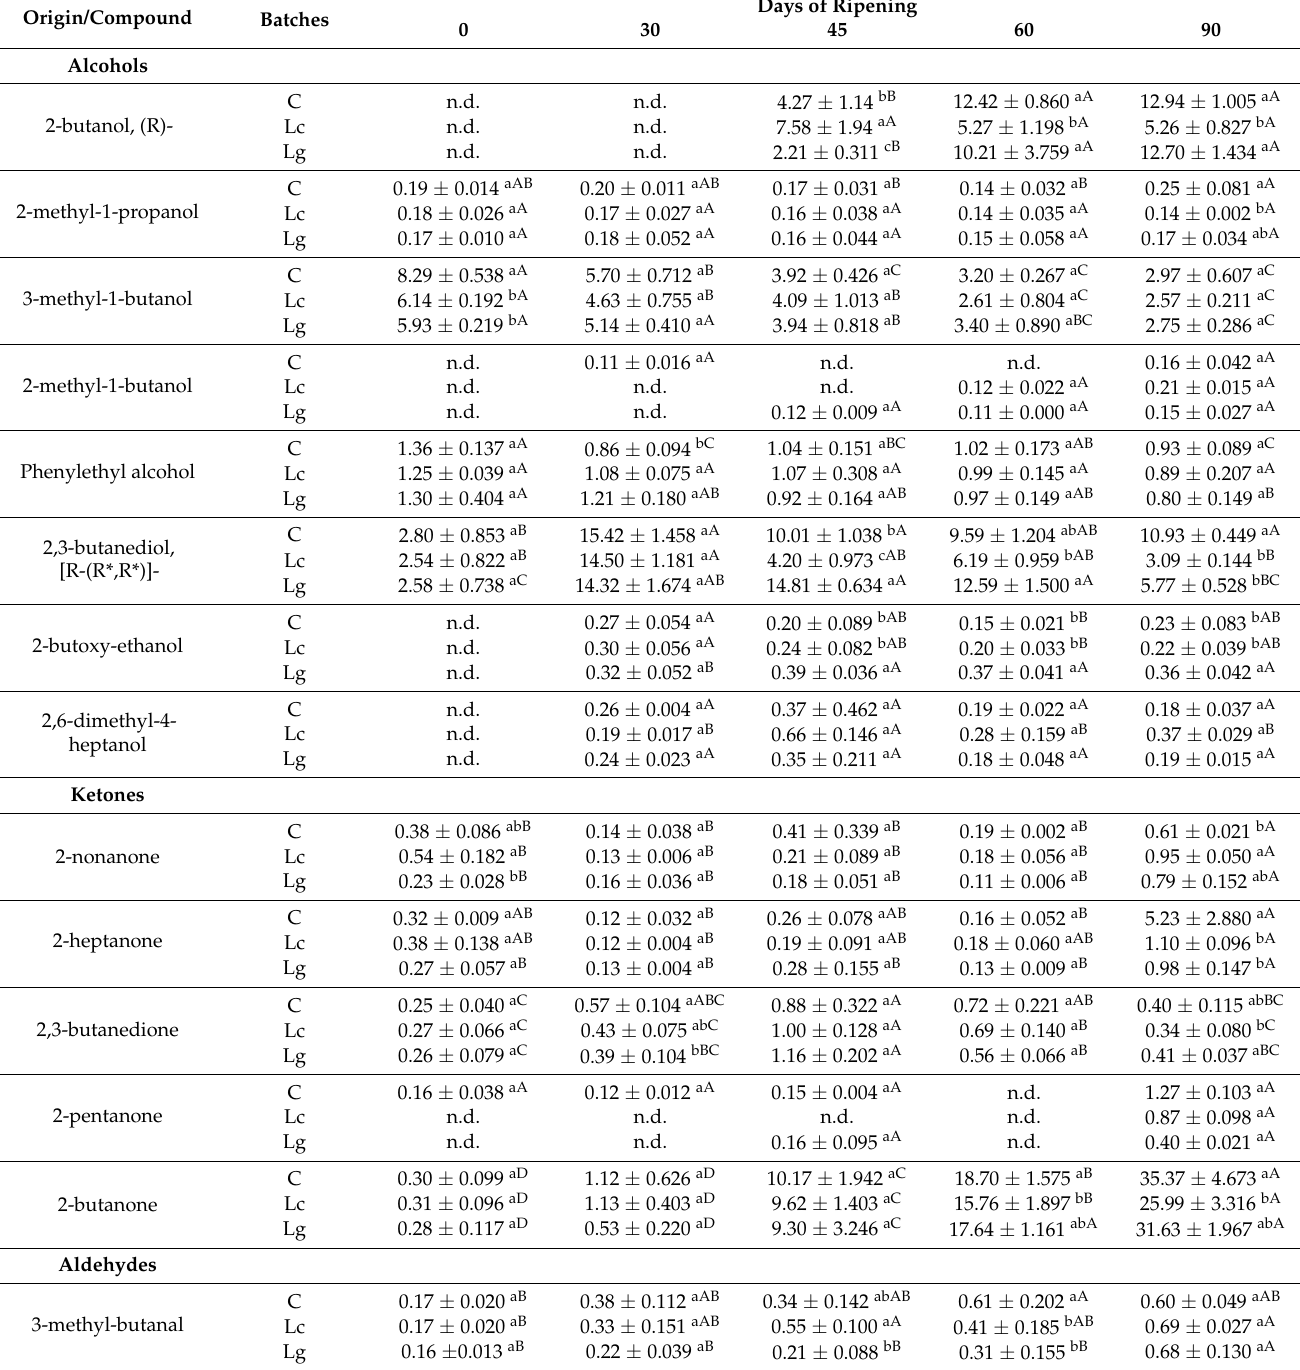
Table 3. Alcohols, ketones and aldehydes (AU × 10 6 ) of “Torta del Casar” cheese during the ripening